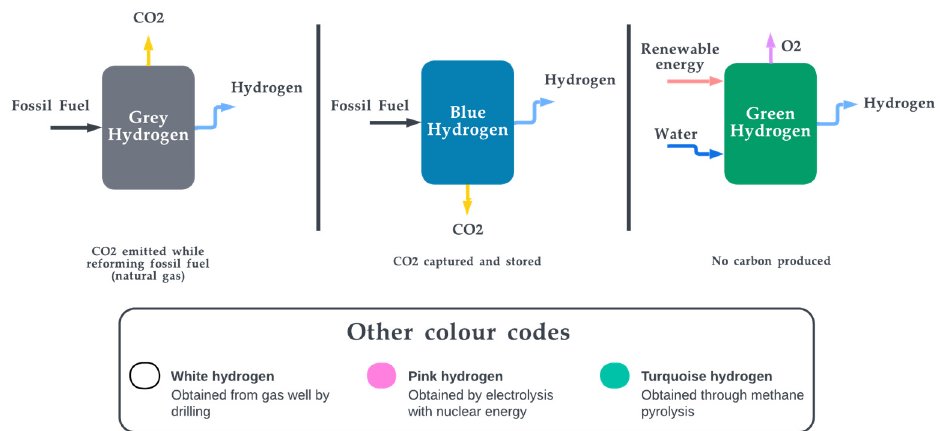
Figure 6. Popular hydrogen colour codes.